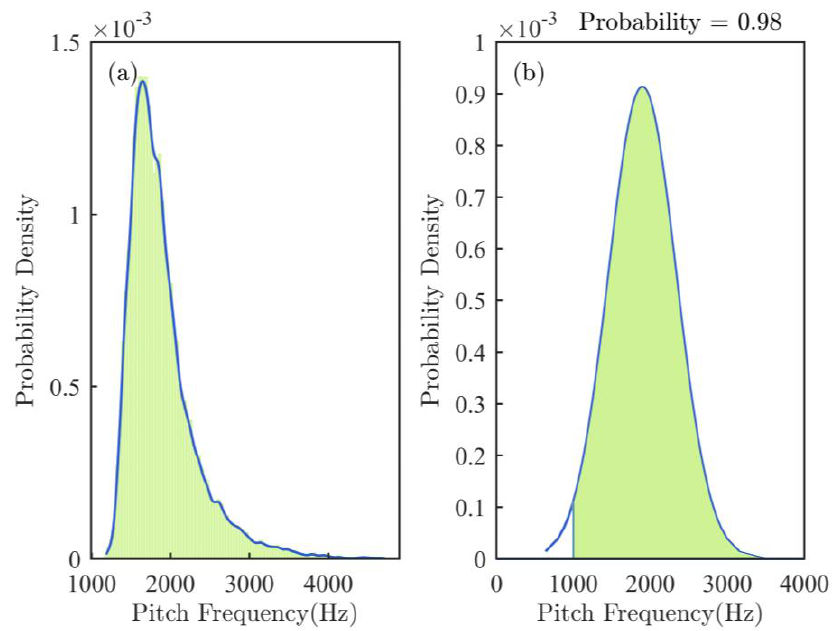
Figure 7. Probability density distribution of the gravel pitch frequency 𝐺𝑓 𝑝𝑖𝑡𝑐ℎ : ( a ) The vertical axis values of the histogram (green part) indicate the probability of the sample falling in each frequency interval, and the blue curve is the probability distribution fitting curve; ( b ) the probability value (shaded green area) calculated using autonomous programming.